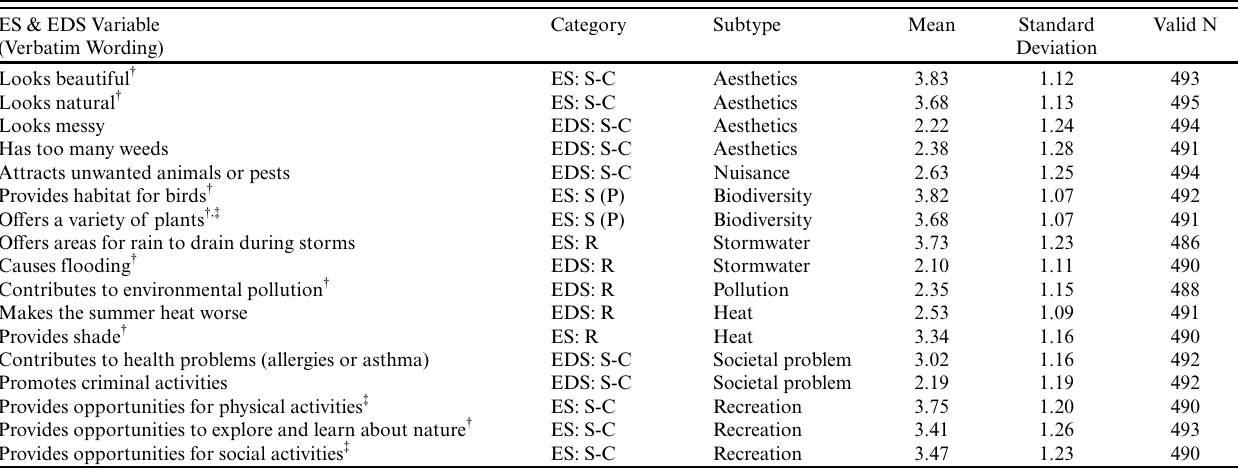
Table 1 . Descriptive statistics for ecosystem services (ES) and disservices